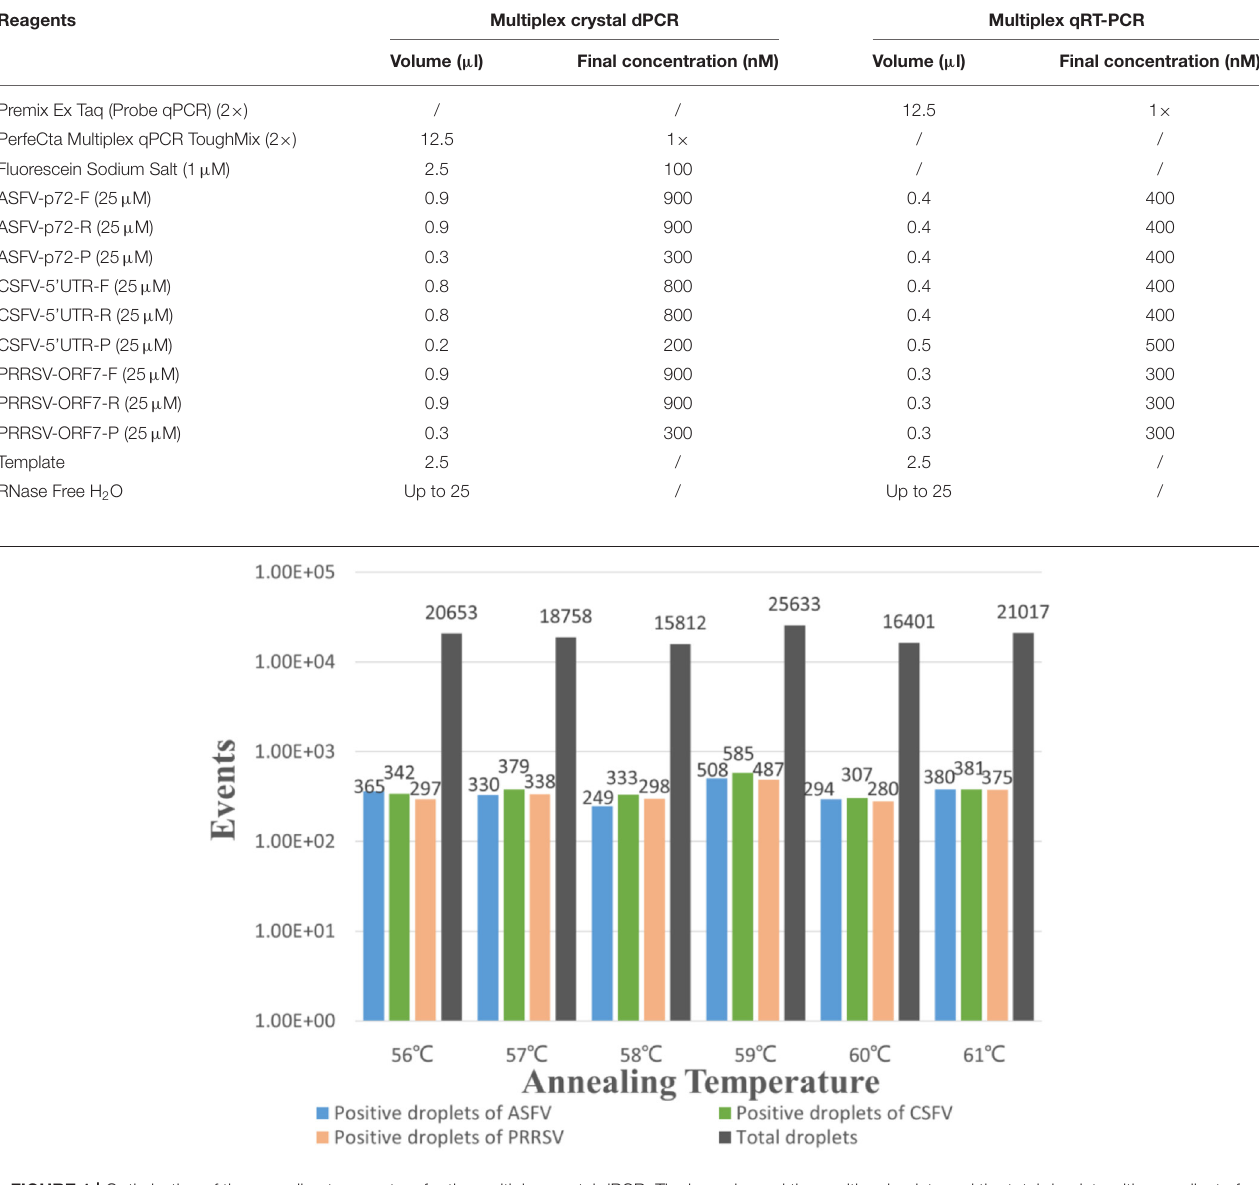
TABLE 2 | The reaction system of the multiplex crystal